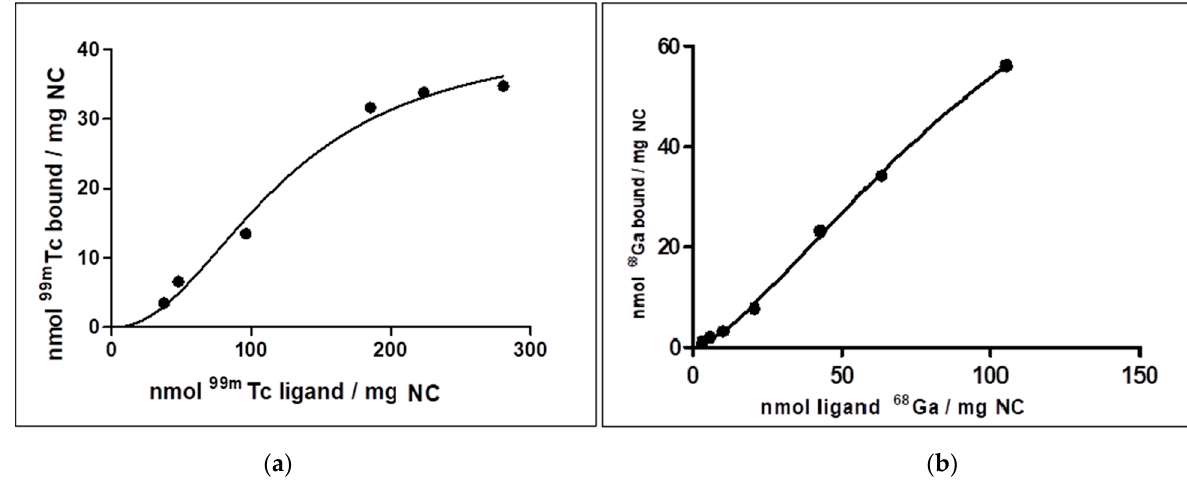
Figure 2. Saturation Binding experiment (one site—Specific binding determined by Hill slope equation), for binding affinity between NC and 99m Tc ( a ) and 68 Ga ( b ).